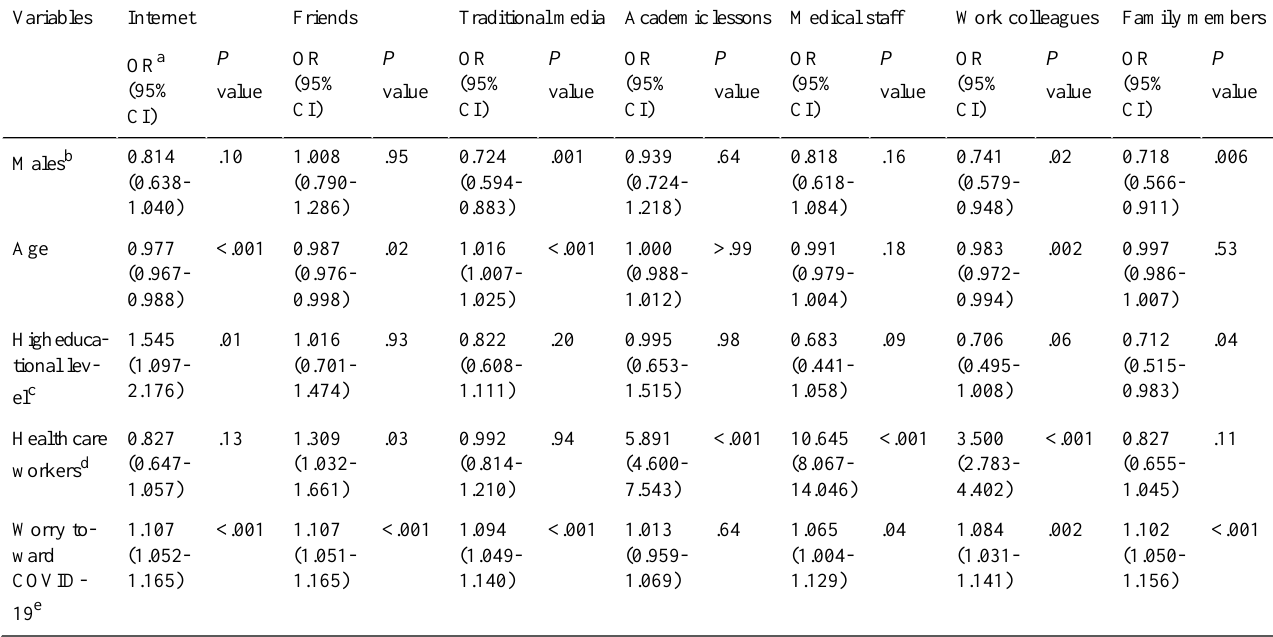
Table 2. Factors related to COVID-19 information sources.